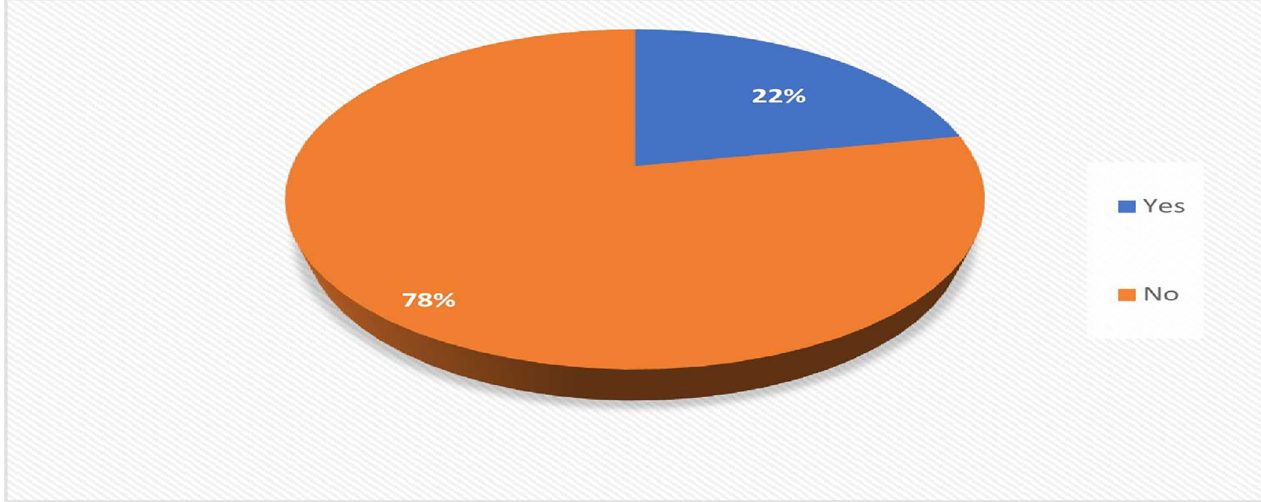
Fig 1. Acceptance of COVID-19 vaccine among pregnant